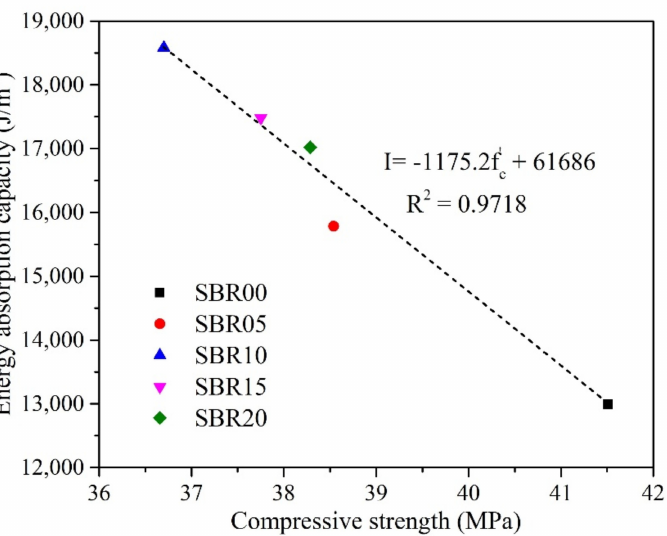
Figure 6. Relationship between compressive strength and energy absorption capacity of SBR latex- modified cement paste at 28